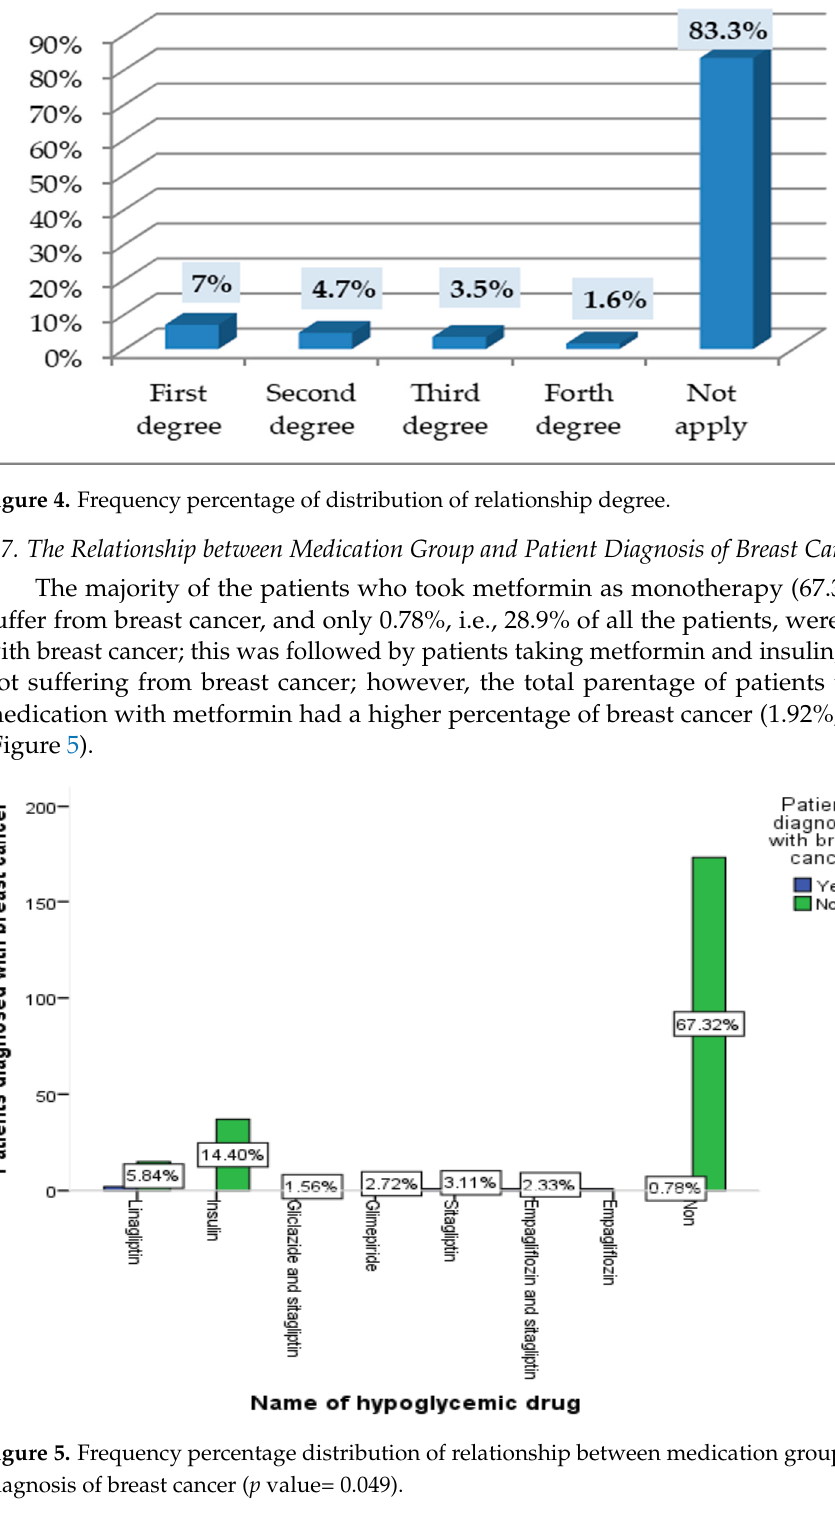
Figure 6. Frequency percentage distribution of relationship between comorbid disease and patients’ diagnosis of breast cancer ( p value 0.78).